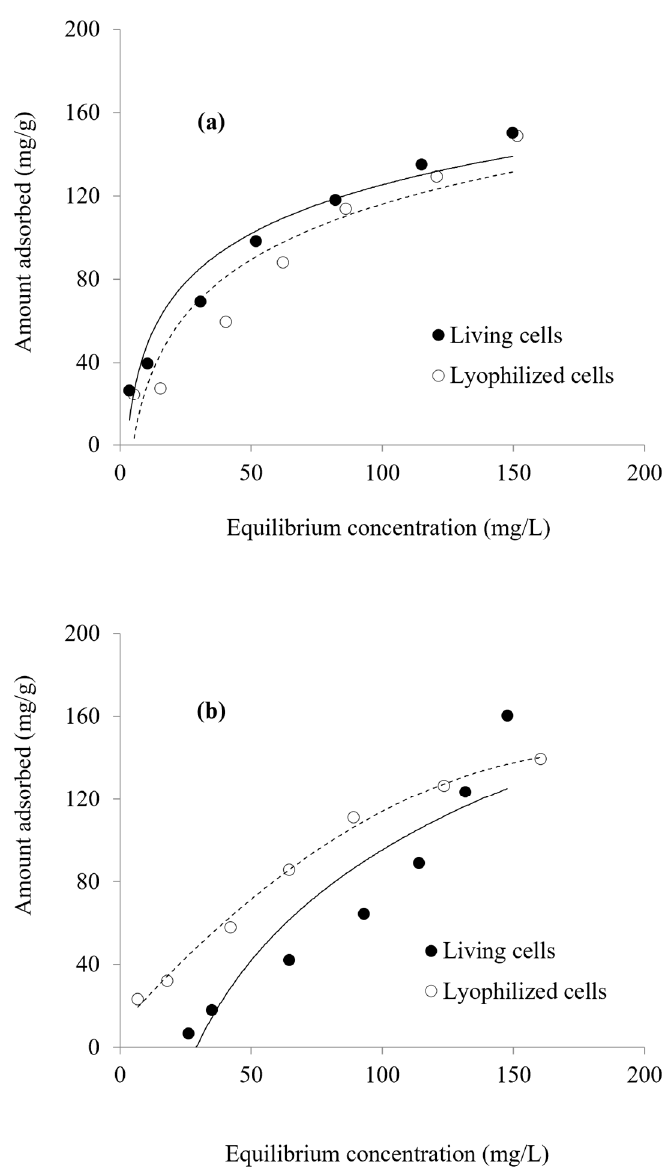
Figure 5. Zn 2+ ( a ) and Cd 2+ ( b ) biosorption by living and lyophilized biomass of Priestia megaterium PRJNA526404.